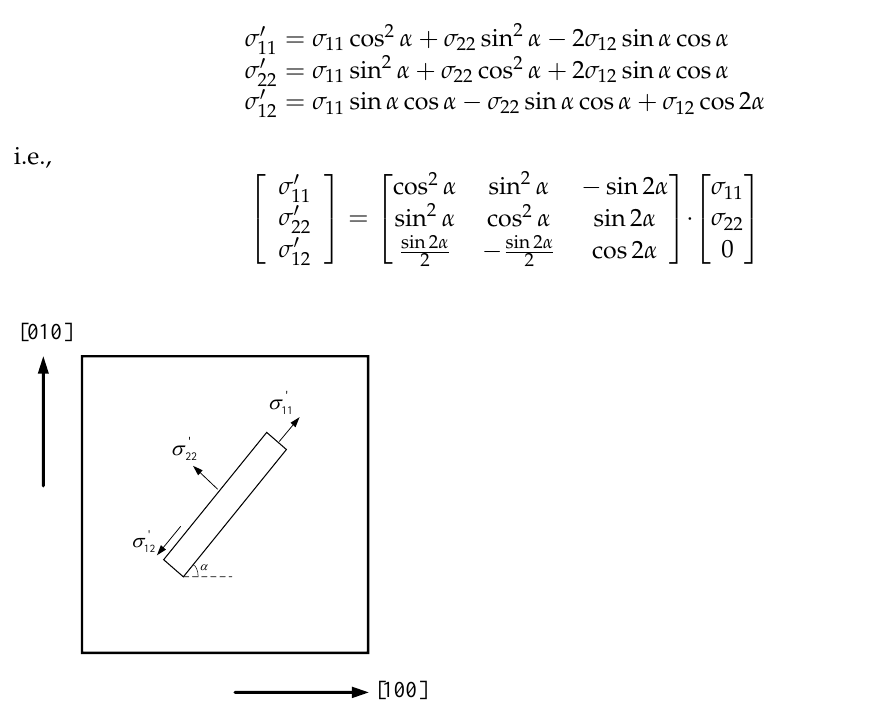
Figure 3. Diagram of piezoresistive forces on the plane (100).